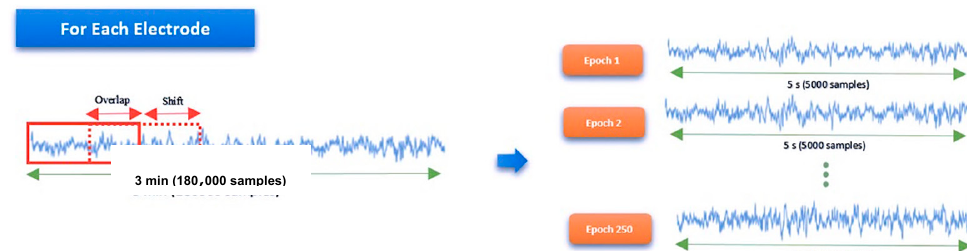
Figure 5. The overlap operation for each electrode.